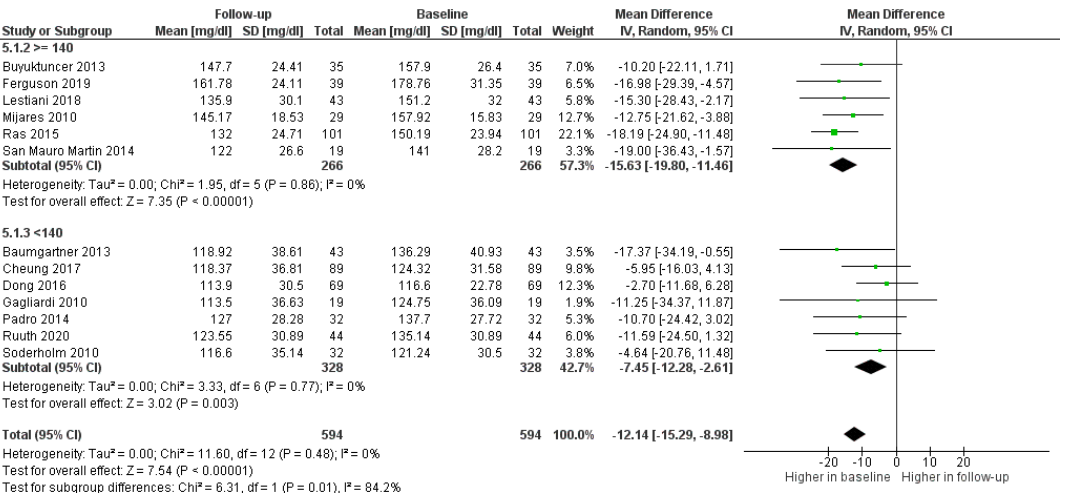
Figure 5. Forest plot comparing different ranges of LDL-c among participants in the treatment